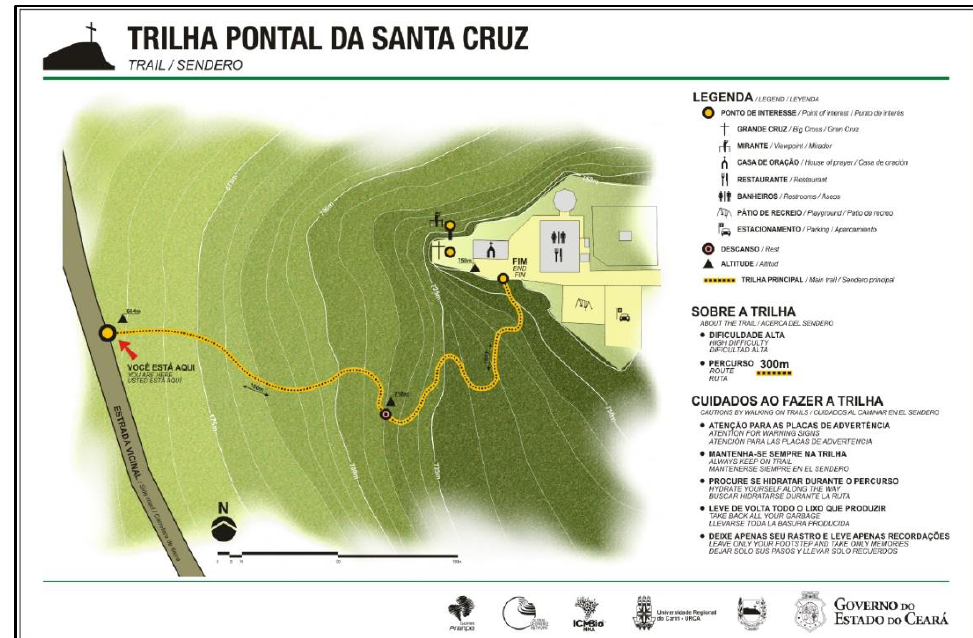
Figure 4. Pontal da Santa Cruz Geosite Trail. Source: Trail Signaling Plan Araripe UGG [82].